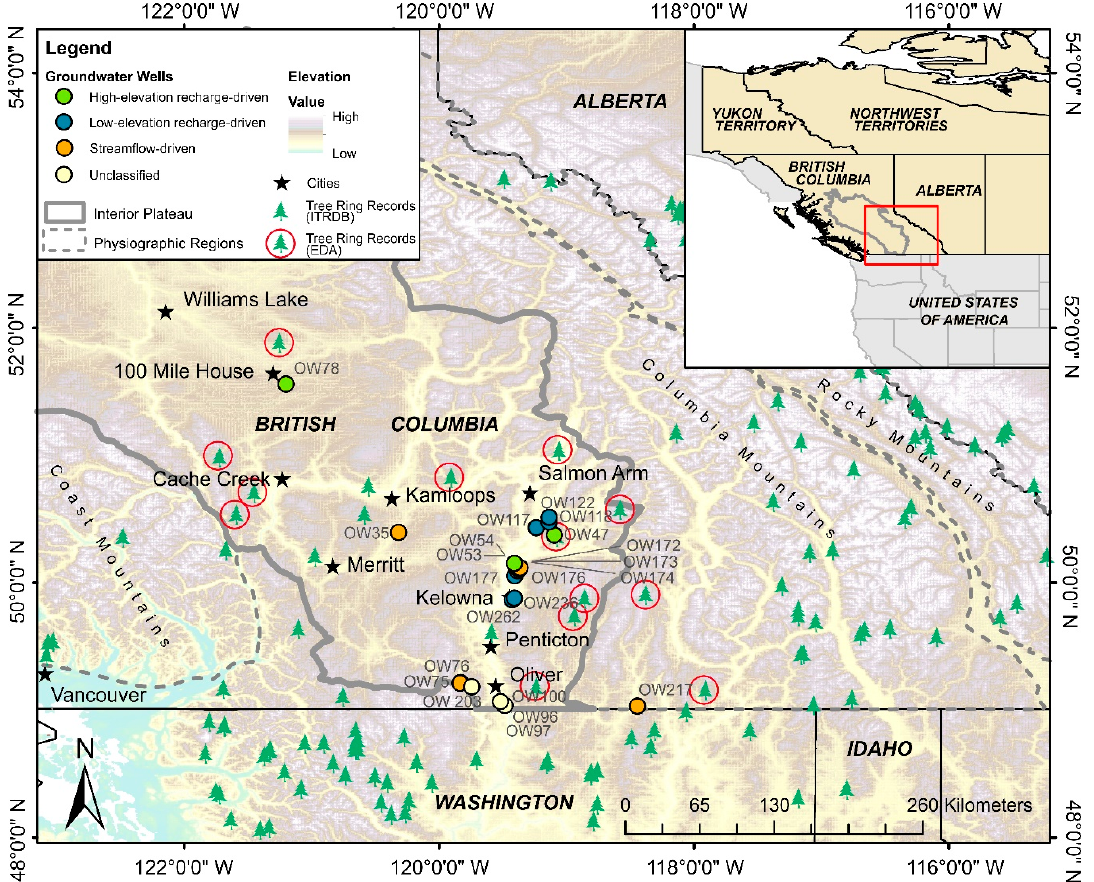
Figure 1. Location map of observation wells within the southern Interior Plateau Region of British Columbia and tree ring records available from the International Tree Ring Database (ITRDB). Tree ring records used for the Explorative Data Analysis (EDA) are circled in red. The inset map shows the location of the study region within western Canada and the northwestern United States. Observation wells are colour-coded by aquifer–stream system type and classified using hysteresis plots as discussed in Section 2.1. Source for basemap digital elevation model (DEM): HydroSHEDS Database, available from http://hydrosheds.cr.usgs.gov.